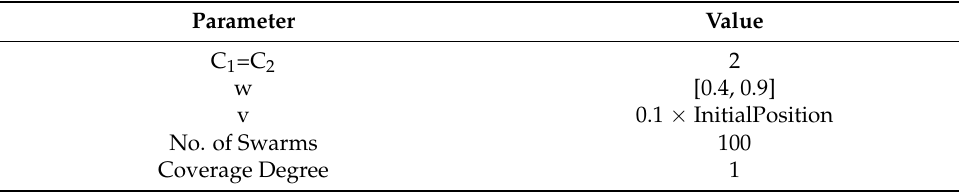
Table 6. Parameters used by PSO algorithm in node deployment.